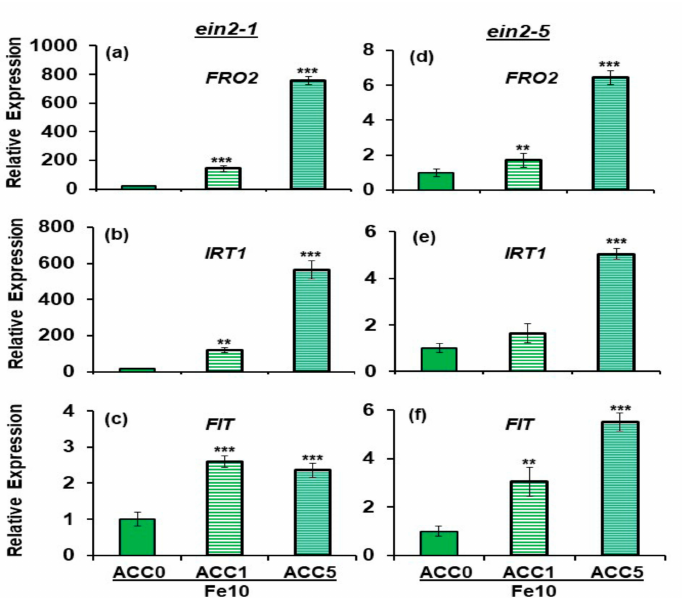
Figure 4. Effect of 1-aminocyclopropane-1-carboxylate (ACC) (ET precursor) on FRO2 , IRT1 and FIT expression in roots of the Fe-sufficient Arabidopsis ET insensitive mutants ein2-1 ( a – c ) and ein2-5 ( d – f ). Plants were grown in complete nutrient solution with 10 µ M Fe-EDDHA (Fe10). ACC, at different final concentrations (0, 1 or 5 µ M), was added to the nutrient solution during the last 24 h. After treatments, roots were collected and kept at − 80 ◦ C for subsequent analysis of mRNA levels. FRO2 , IRT1 and FIT expression were determined. Relative expression was calculated in relation to the Fe10 treatment. Data represent the mean of 3 independent biological replicates ± S.E. Bars with ** or *** indicate significant differences ( p < 0.01 or p < 0.001) in relation to the Fe10 treatment according to the Dunnett’s